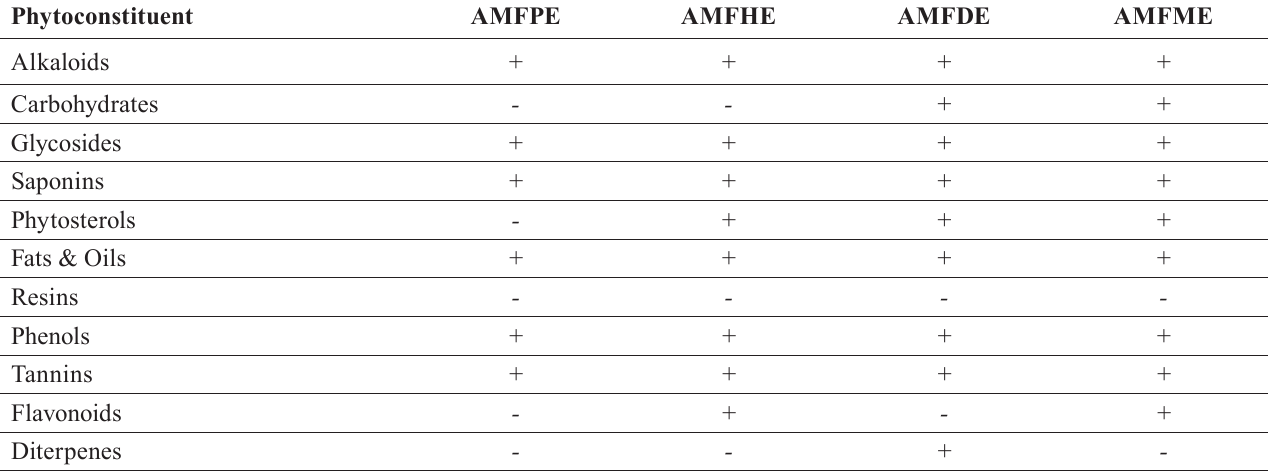
TABLE I - P hytochemical specifications of different extracts of flowers of A. malaccensis